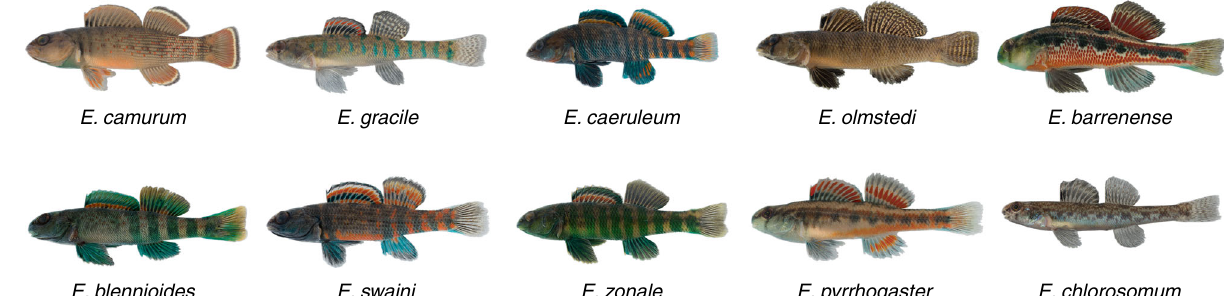
Fig. 1 Images of males of each species included in this study. Pictured are males in breeding